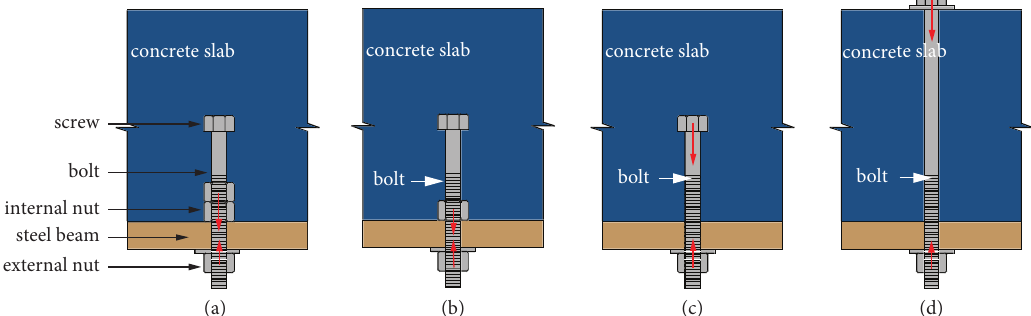
Figure 1: Bolted shear connectors: (a) double-embedded nuts; (b) single-embedded nut; (c) without embedded nut; (d) friction-grip